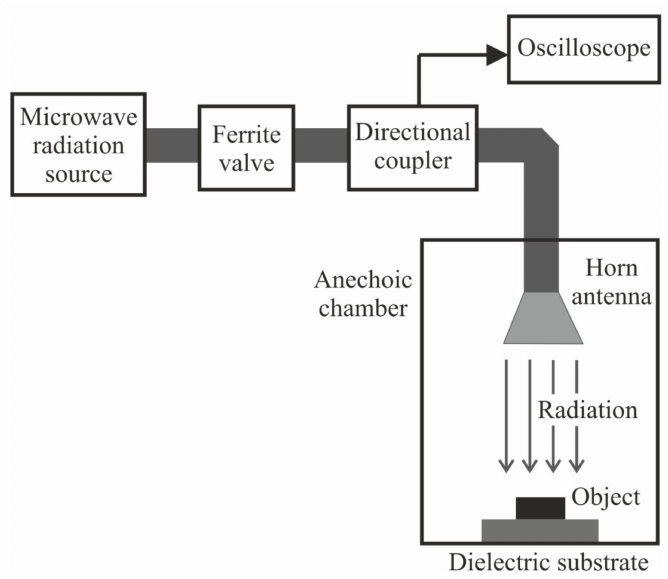
Figure 2. Scheme of an experimental setup for studying the effect of microwave radiation on metal powders.